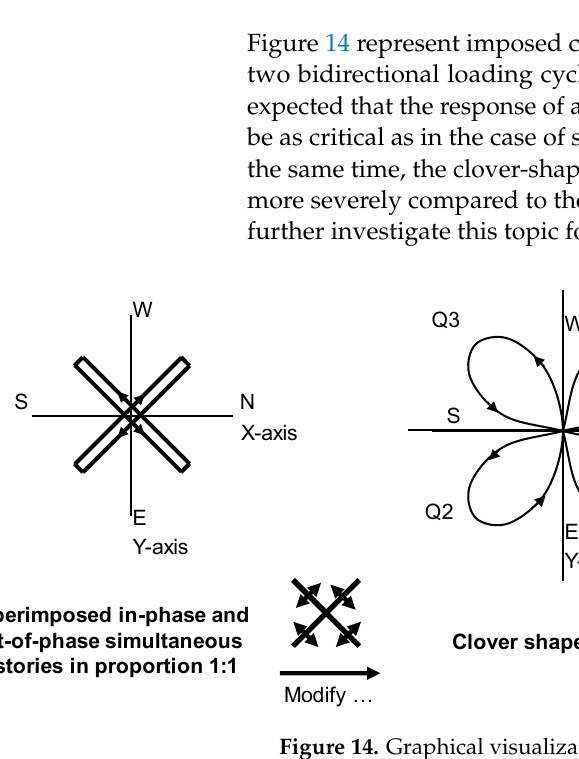
Figure 14. Graphical visualization of clover-shaped history.